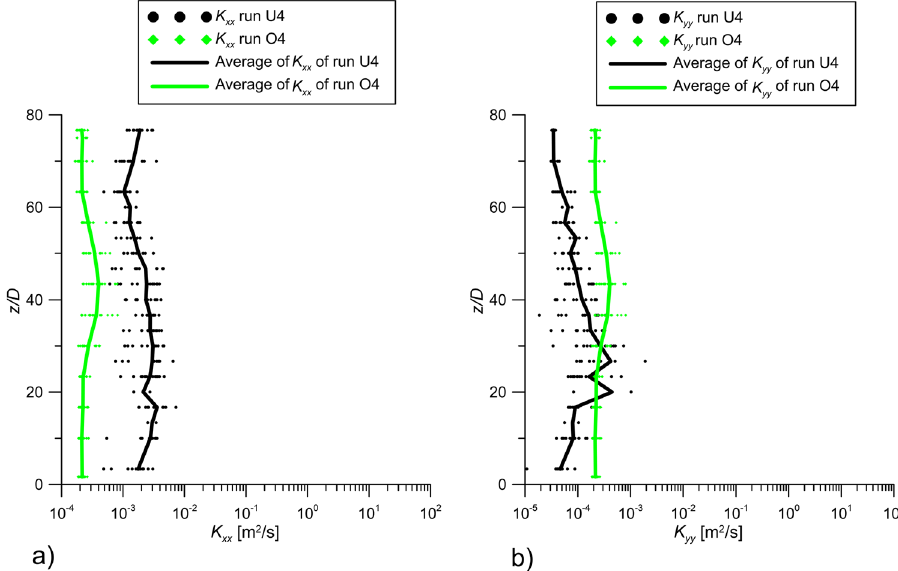
Figure 7. Values of K xx and K yy of runs U4 and O4 with the line of the averaged-values.